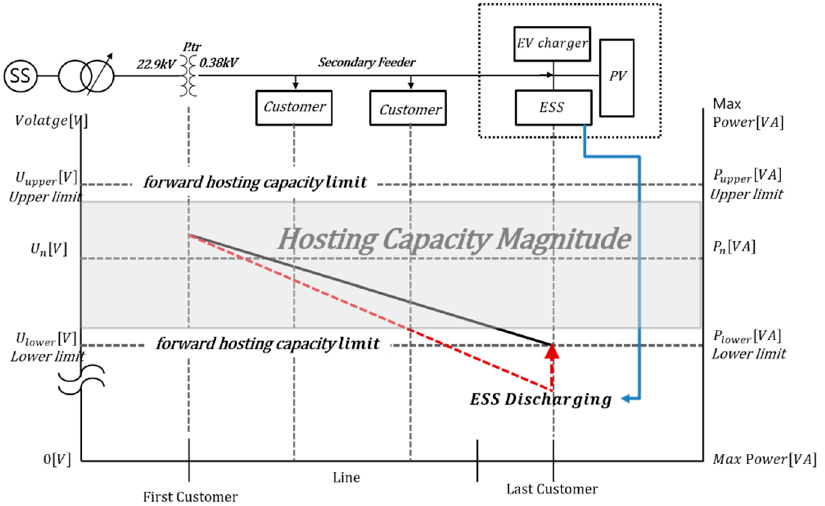
Figure 2. Operation strategy of VPL ESS in case of lower limit.